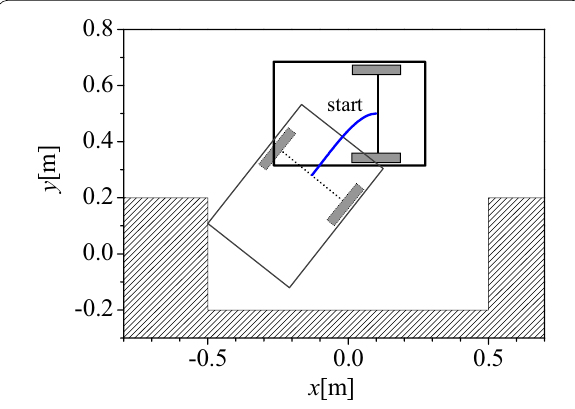
Fig. 4 Numerical simulation result of parallel parking, ( x 0 , y 0 , θ 0 ) (0.1, 0.5 m, =